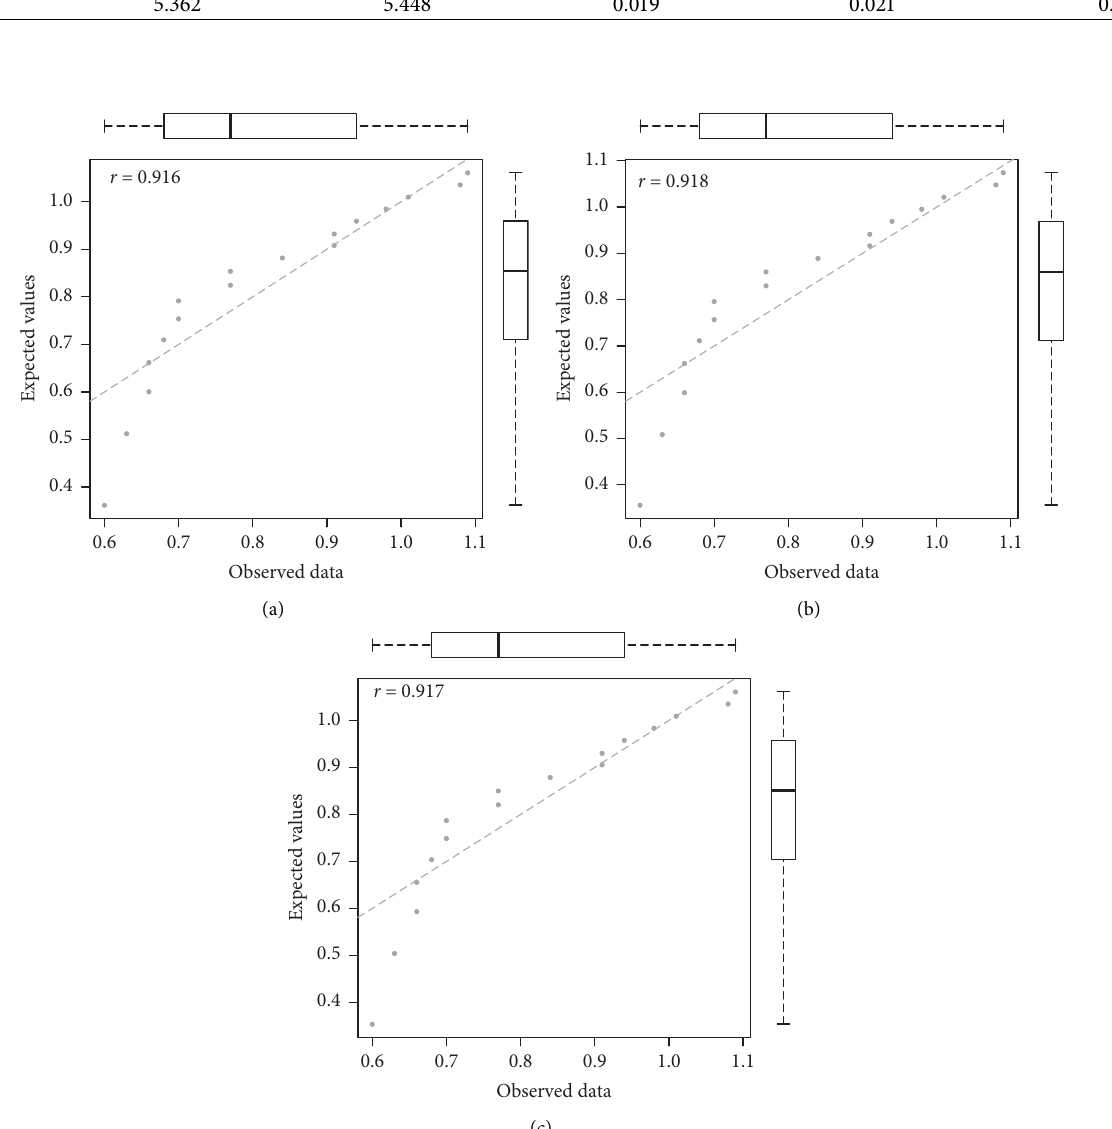
􏽢 θ ( 􏽢 λ ) ; (c) the weighted least-estimators 􏽢 λ p and p p